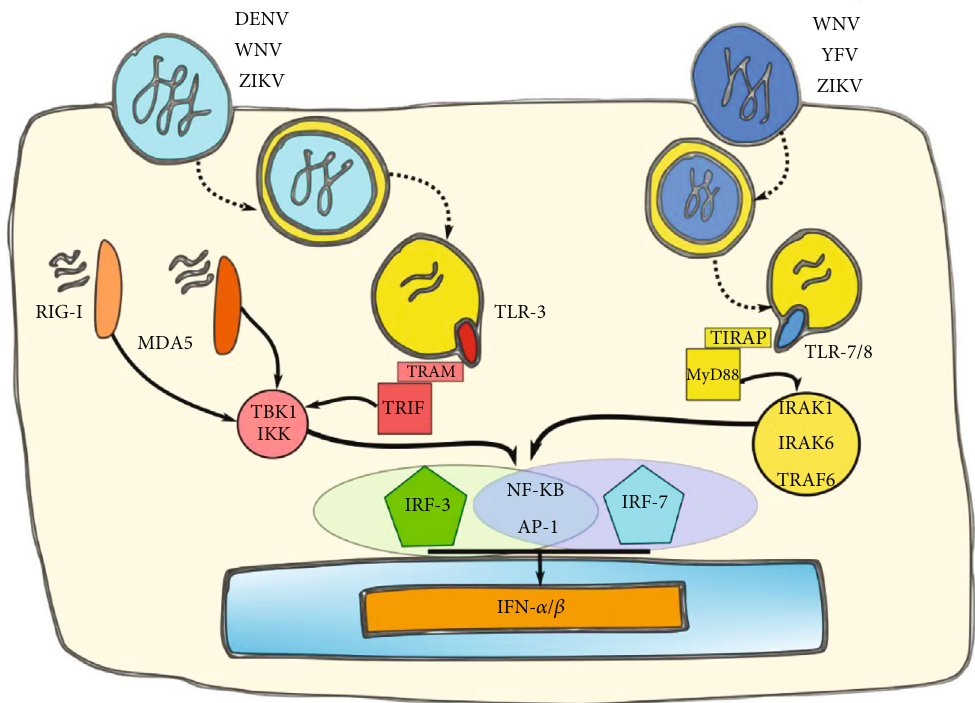
Figure 5: Induction of IFN-I by fl aviviruses. The TLR and RLR signaling cascades converge with the activation of transcription factors, which are critical for the induction of IFN- α ∕ β